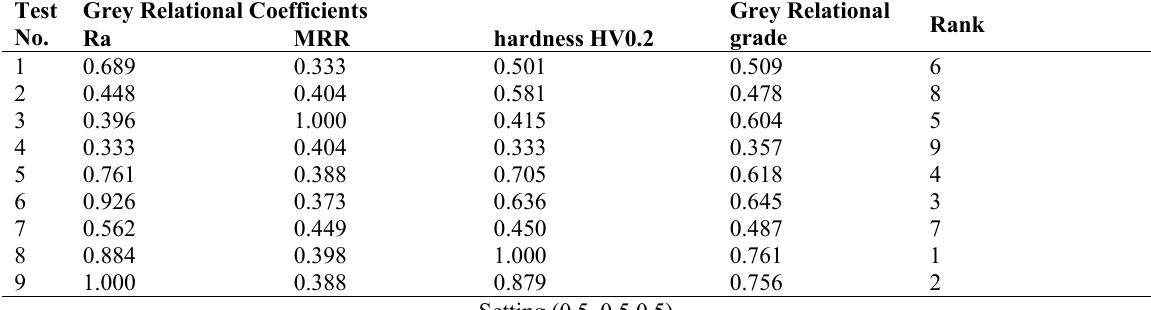
Grey relational coefficients and grades with